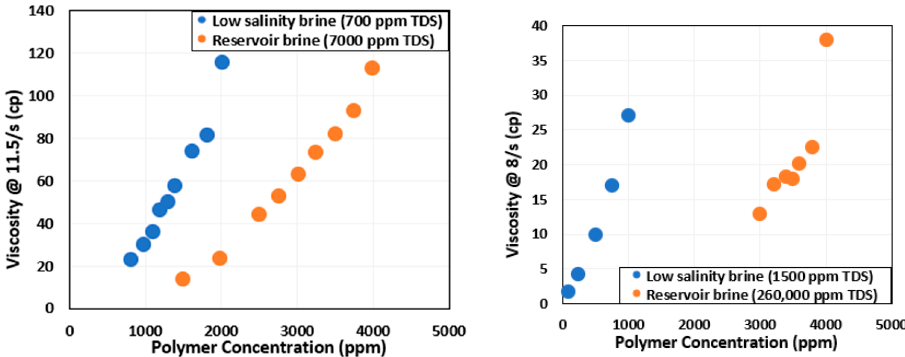
Figure 10. Reductions in HPAM concentrations using LSW as the makeup brine [119].